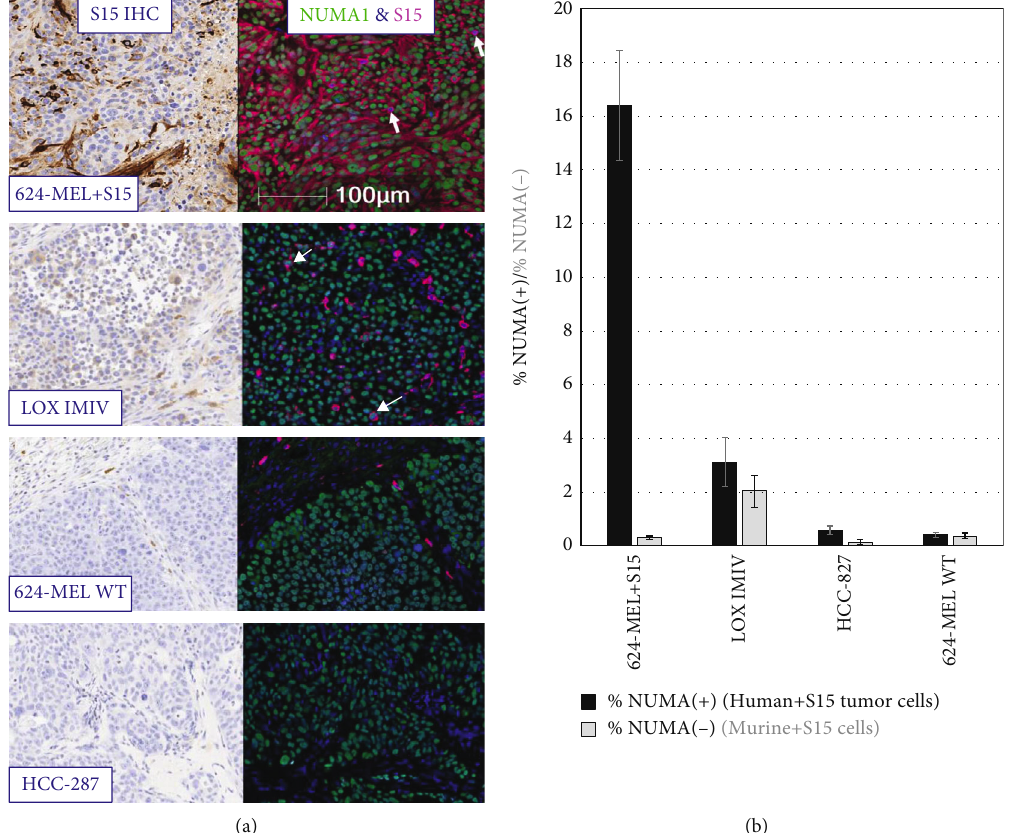
Figure 8: (a) Representative images of Siglec-15 (S15) IHC and dual immuno fl uorescence staining (NUMA1&S15) of 624-MEL+S15, LOX IMIV, HCC-827, and 624-MEL WT tumors from xenograft mice to distinguish positive Siglec-15 (+S15) human tumor cells (green (NUMA1, human nuclear marker) and pink (+S15)) from mouse +S15 immune cells in the TME (blue (mouse) and pink (+S15)); white arrows identify human tumor cells (NUMA(+)) positive for S15. (b) Quanti fi cation of human tumor cells positive for S15 (% NUMA(+)) and murine +S15 cells (% NUMA(-)) of each tumor type from dual immuno fl uorescence stained images; each bar represents the mean ± SE ( n = 8 , 624-MEL+S15 tumors; n = 6 , LOX IMIV, HCC-827, or 624-MEL WT